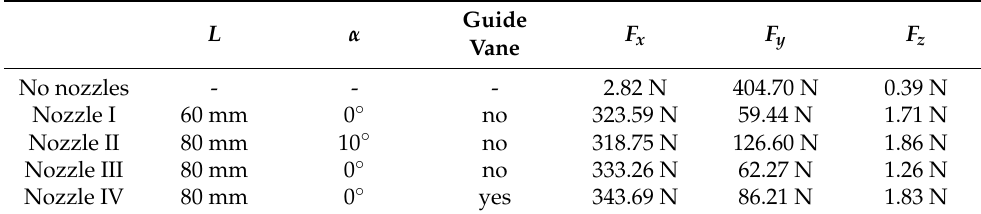
Figure 5. The 3D-printed nozzles: ( a ) four sizes of nozzles; ( b ) right view of nozzle IV. Table 3. Nozzle size parameters and force test